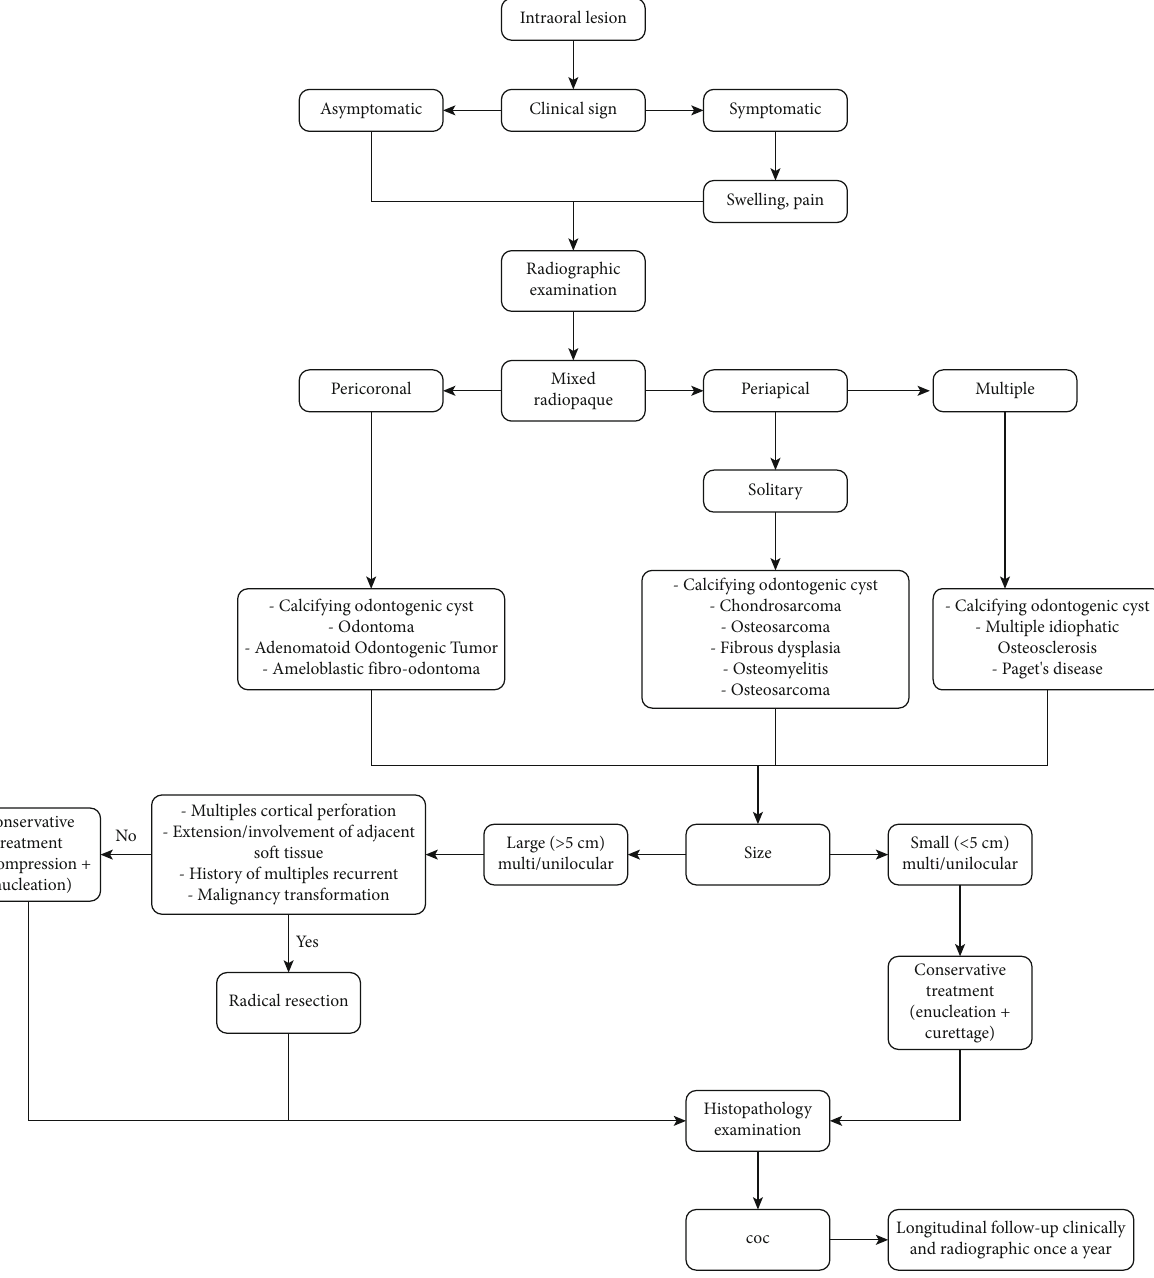
Figure 11: Algorithm to diagnose and manage cystic lesions